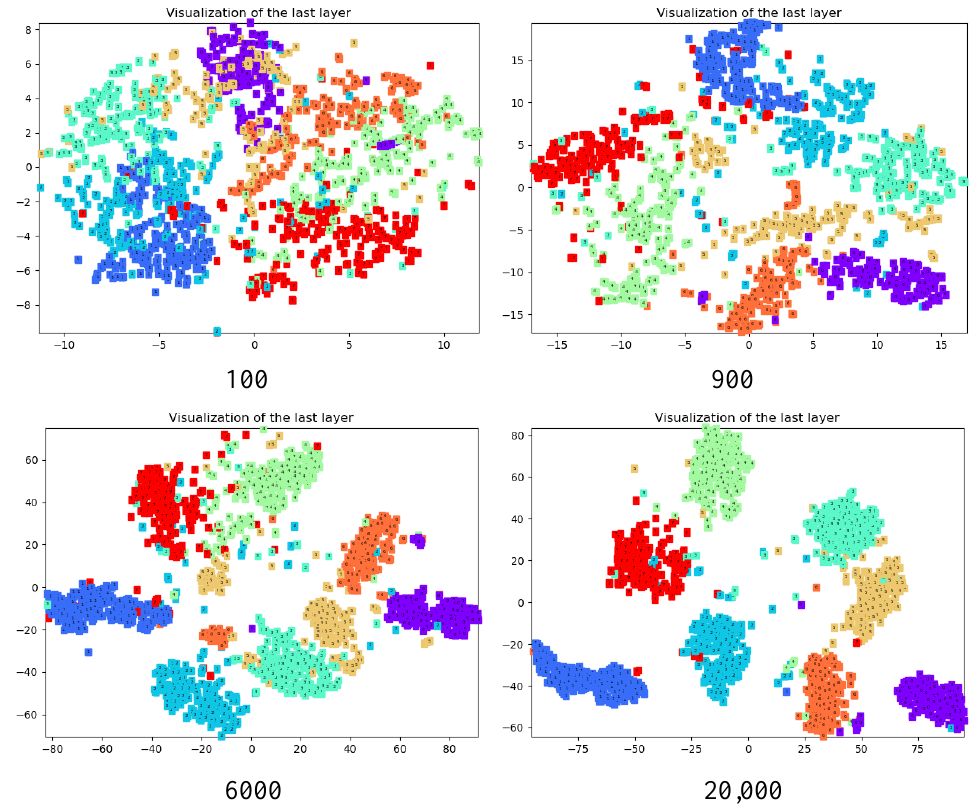
Figure 14. Visualizing test samples from the last hidden fully connected layer with t-SNE under different training data